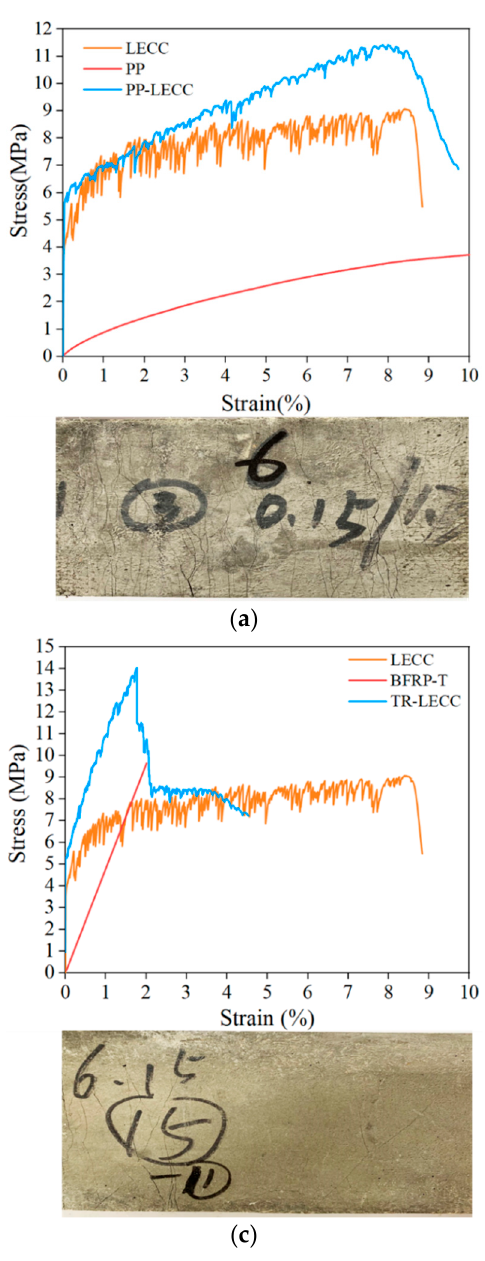
Figure 10. Reinforcement effect of reinforcement textile types and crack diagram: ( a ) PP textile, ( b ) BFRP textile, and ( c ) BFRP grid.